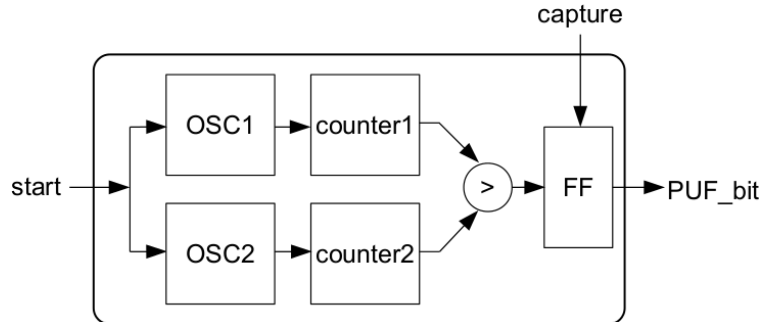
Figure 3. PUF bit